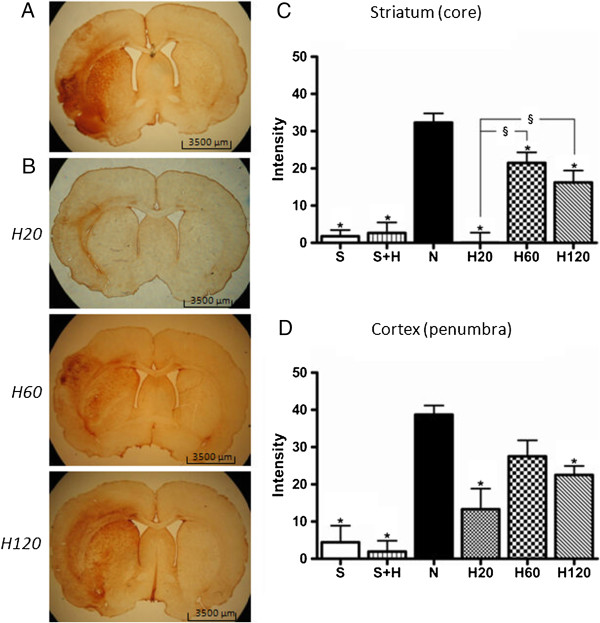
Effect of hypothermic treatment on the Et-1 induced increase in GFAP expression. Activation of astrocytes as determined by the expression of GFAP (A) in a N rat and (B) in a H20, H60 and H120 rat, 24 hours after the administration of Et-1. The graphs show the overall expression in striatum (C) and cortex (D) of the different treatment protocols. The number of rats in the S and S + H group is 7 and 4 respectively; in the N pool 12 and in every H group 7. *Significantly different compared to the N group. §Significantly different (p < 0.05) from each other. For a more detailed image we refer to a previously published article by Ceulemans et al.
[37].